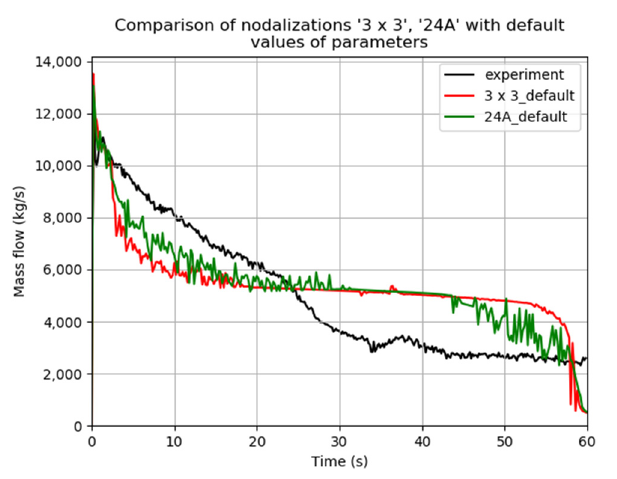
compared with the experimental data.